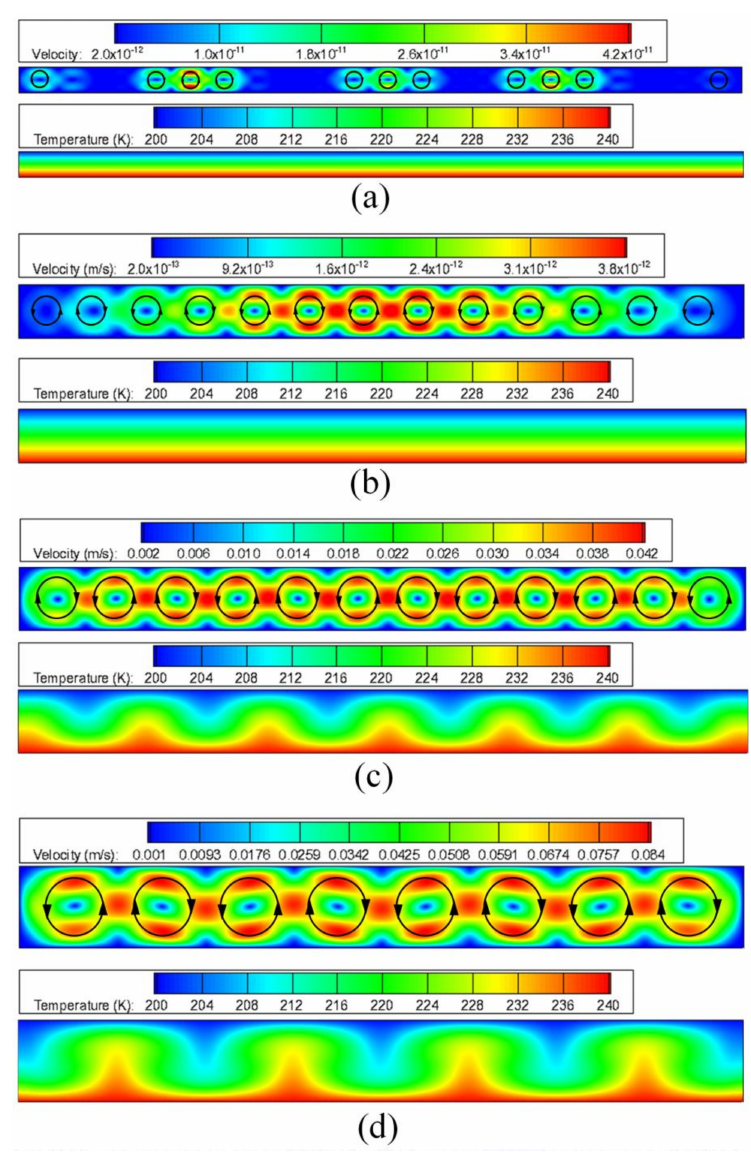
Figure 6. Velocity and temperature contours in the horizontal enclosures at L = 1000 mm, ∆ T = 40